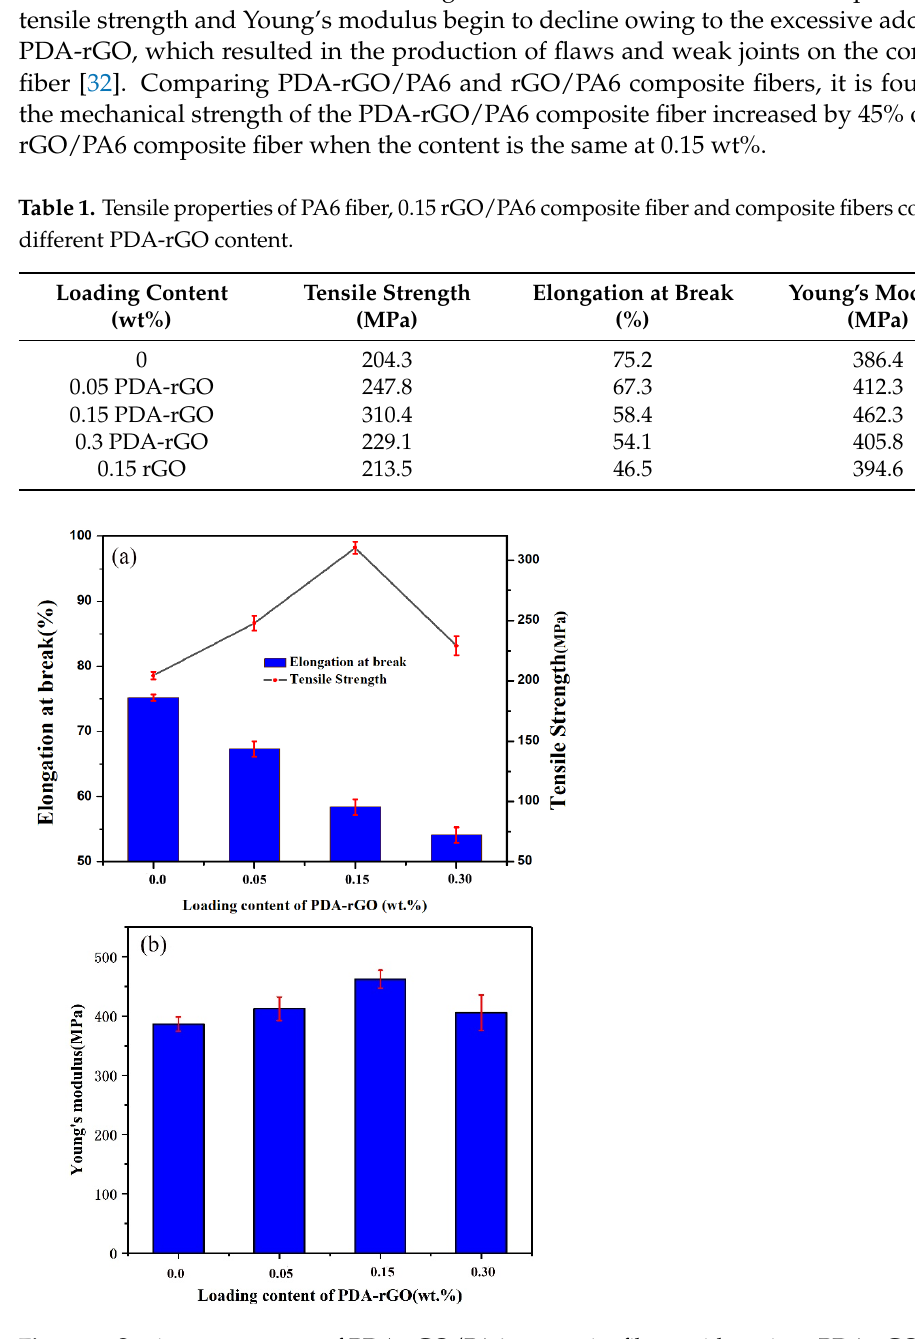
Figure 8. Strain–stress curves of PDA-rGO/PA6 composite fibers with various PDA-rGO content ( a ) and Young’s modulus ( b ).